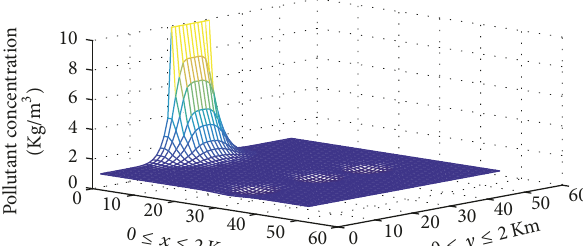
Figure 9: Approximated pollutant concentrations when the third zonal removal mechanism system is